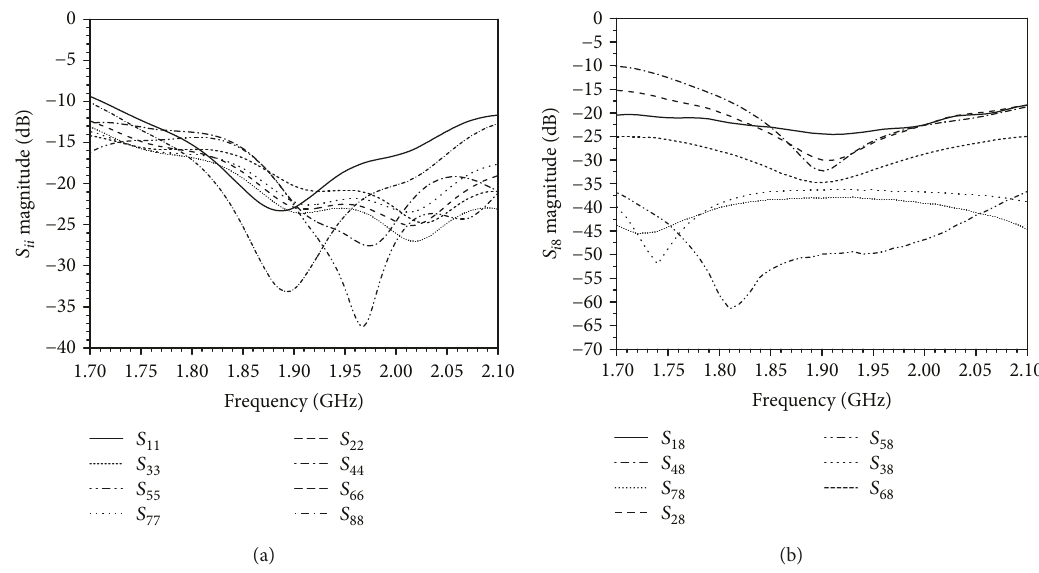
Figure 8: Measured (a) return loss and (b) isolation (magnitude) of the 8 × 8